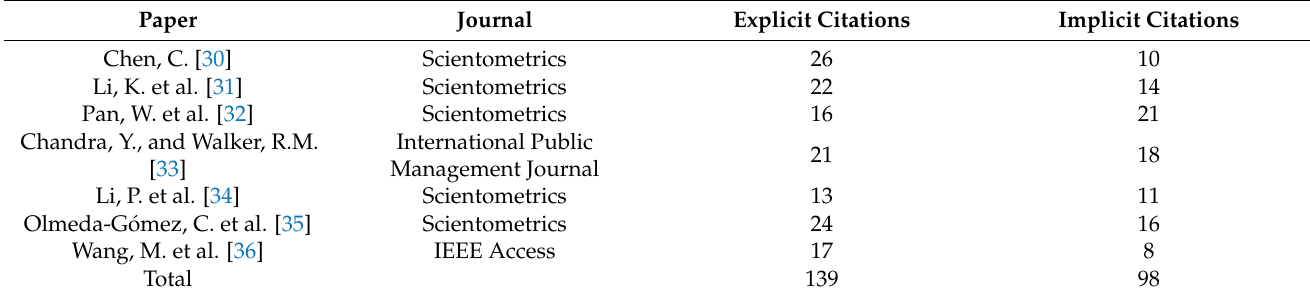
Table 3. Sample papers selected for building the experimental